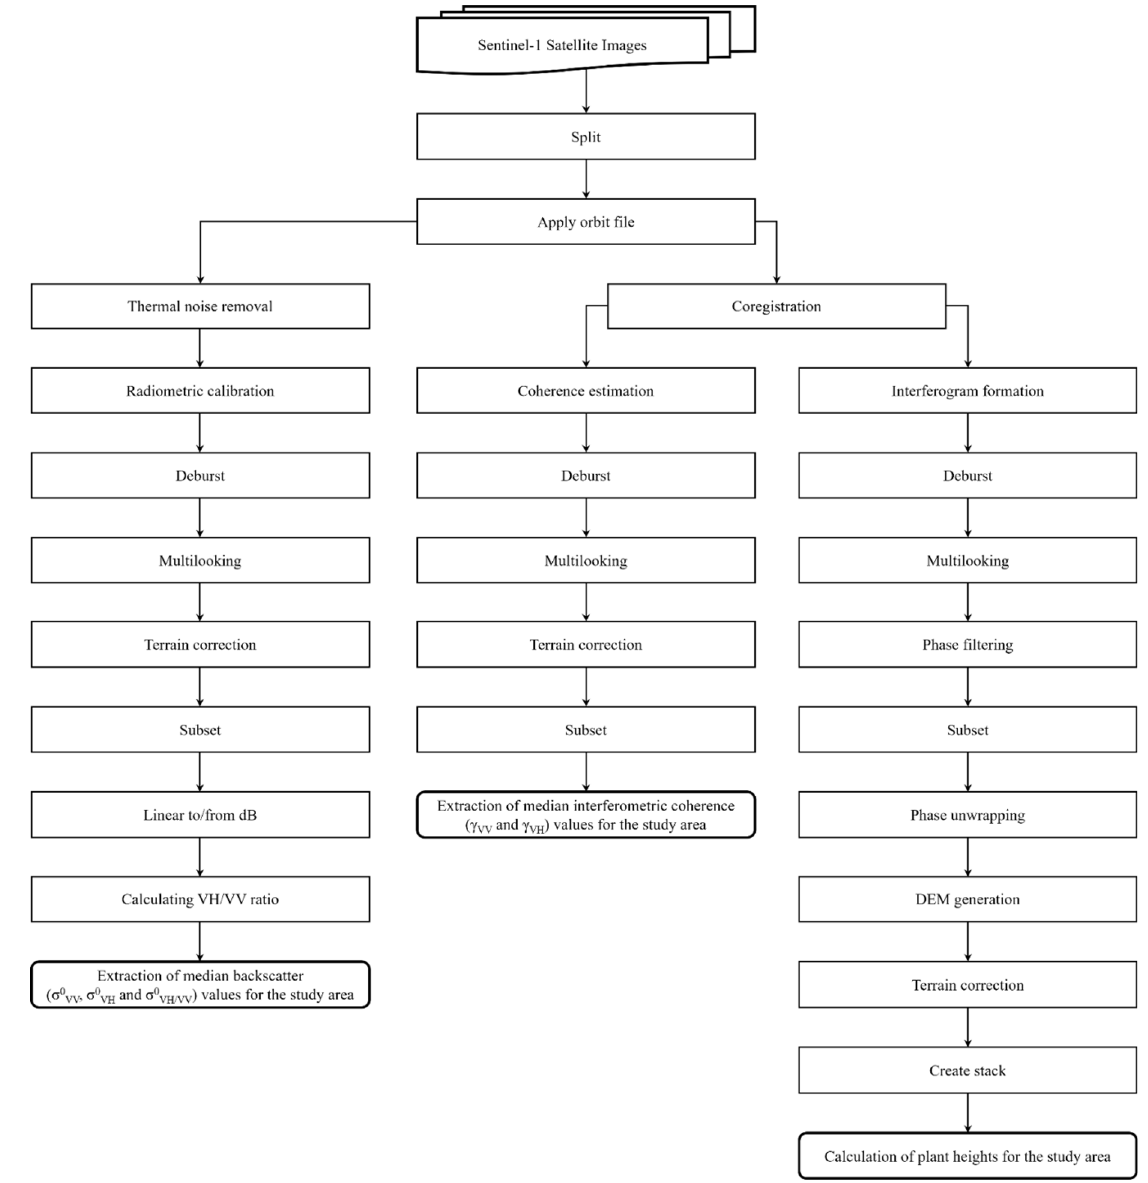
Figure 5. Flowchart for processing Sentinel-1 satellite images.